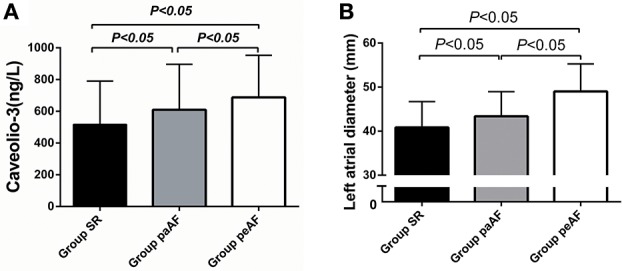
Differences of Caveolio-3 concentrations (A) and left atrial diameter (B) among three groups.